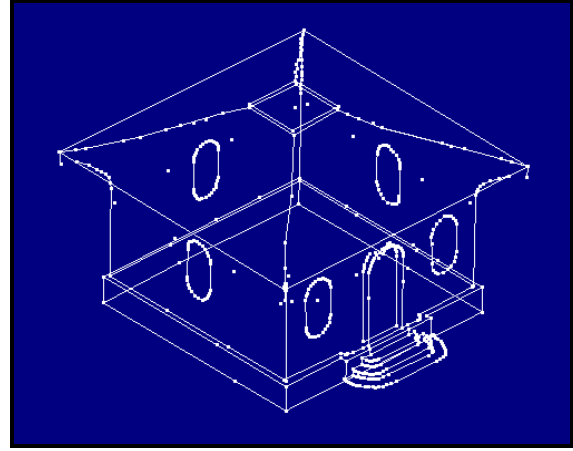
Figure 5: The vectorising